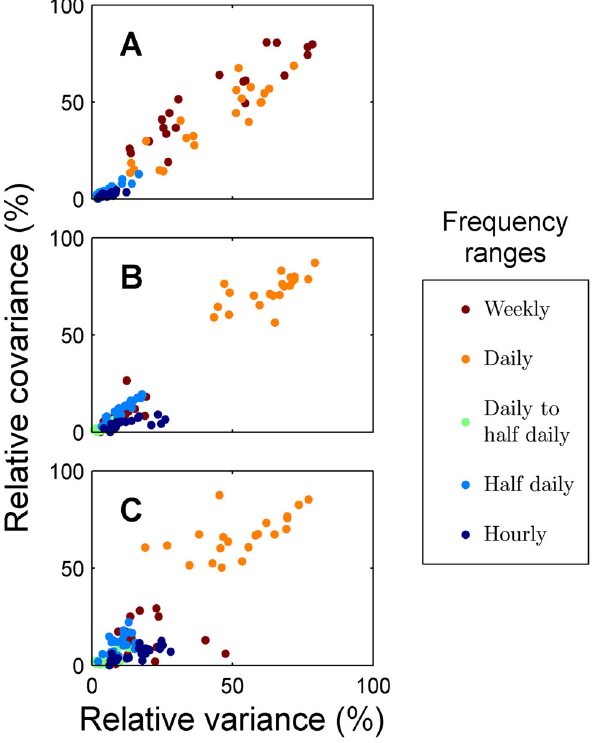
Figure 4. Relative decomposed covariances vs. variances. Relative decomposed covariances derived from cross-spectral analyses between transect sites and long-term station vs. relative decomposed variances derived from auto-spectral analyses of transect sites. (A) Temperature, (B) Dissolved oxygen concentration, (C) pH.